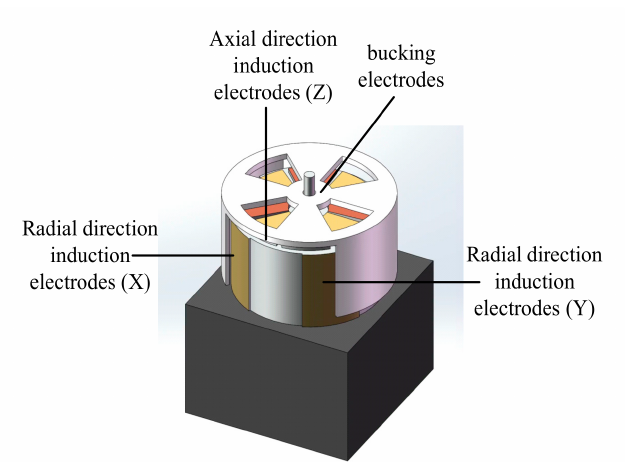
Figure 1. Model of field mill type three dimensional electric field sensor.